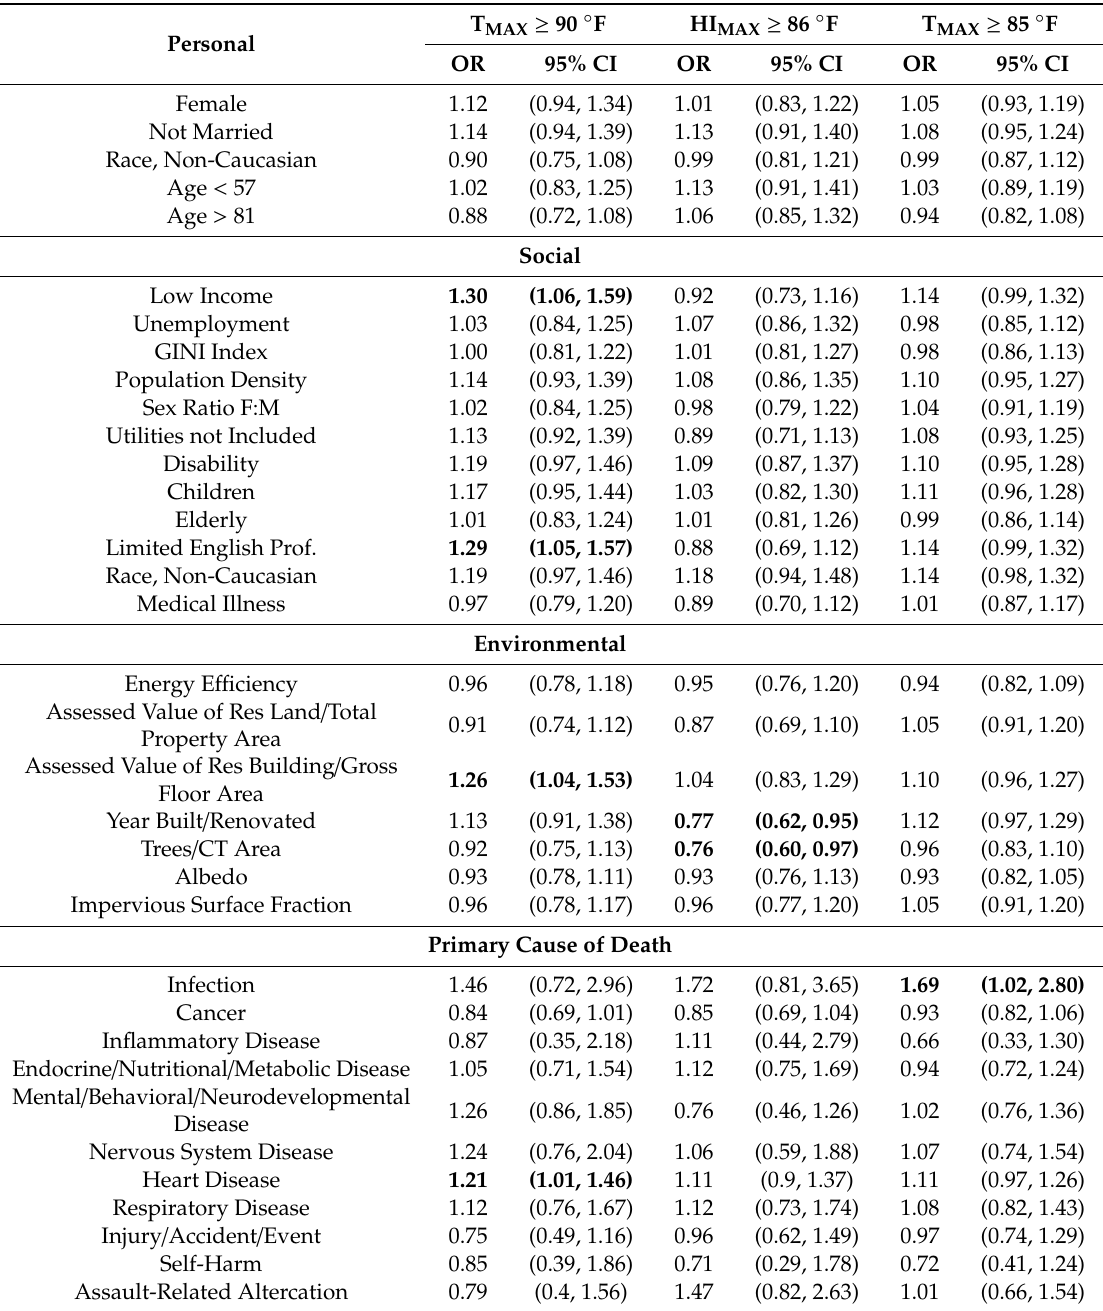
Table 2. The relative odds ratio (OR) of dying at home during extreme heat, during the warm season for those who had the following characteristic (Personal, Primary Cause of Death) or lived in a census tract with the characteristic (Social, Environmental), compared with those who did not have that characteristic, Boston, 2000–2015. Individuals were considered to either have a personal modifier or not, or were dichotomized based on being either below the 25th percentile or above the 75th75th percentile of the values for neighborhood modifiers across Boston or dying from that specified primary cause of death. Bold indicates the OR is significant at an p <